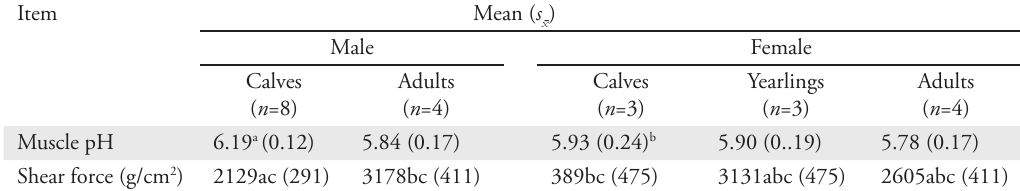
Table 5. Effect of sex and age cohort (calves, yearlings, and adults) on mean (standard error of the mean s and shear force values (g/cm 2 ) of loin steaks of free-ranging reindeer slaughtered on Nunivak Island, Alaska, January, 1993.